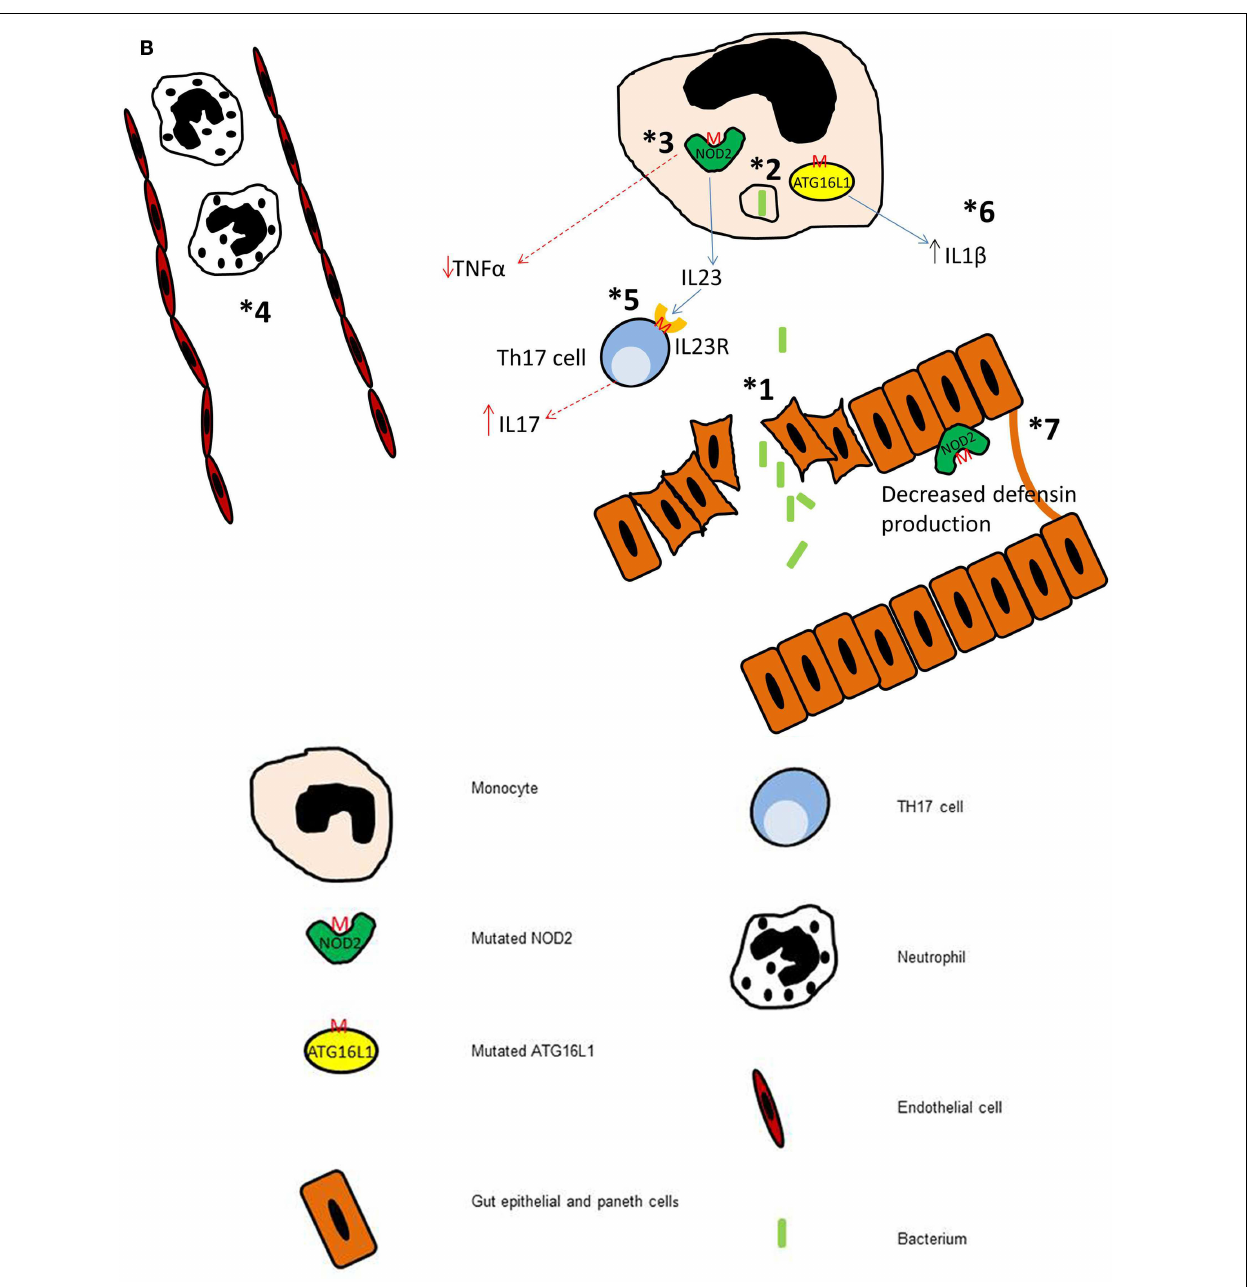
extravasation ofThl cells and monocytes. (f)Thl cells secrete IFN γ which stimulates monocytes to differentiate into macrophages. (B) Diagrammatic representation of the multistep pathogenesis of Crohn’s disease. (1) Loss of integrity in the gut epithelium allows bacteria to leave the lumen and enter the tissue of the gut. (2) Defective autophagy. (3) Mutation of NOD2 leads to reduction in secretion of pro-inflammatory cytokines includingTNF α . (4) Defect in Neutrophil function (monogenic diseases) or reduced chemotaxis (inherited or due to reducedTNF α secretion).This leads to persistence of bacterium in the tissues. (5) Mutational the IL23R onThl7 cells leads to increased survival of these cells and increased IL17 production. High levels of IL17 is associated with increased bowel inflammation in Crohn’s. (6) Mutation of ATG16L (T300A) leads to a excessive of production of IL-l β . (7) Mutation in NOD2 leads to reduced defensin production by intestinal Paneth